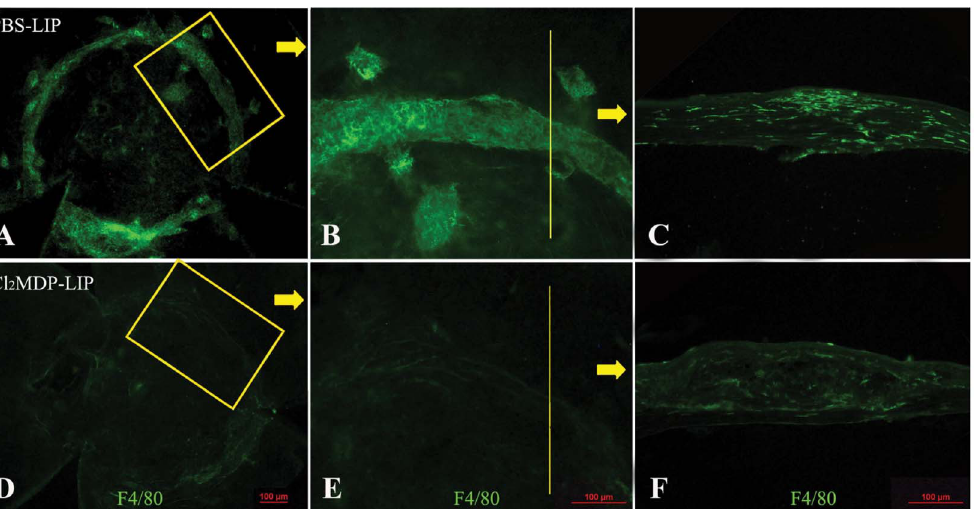
Figure 2. Sub-conjunctival Cl 2 MDP-LIP injection prevented the infiltration of macrophages. Corneal flat mount staining after 14 days of penetrating keratoplasty showed a number of F4/80 + macrophages near the suture sites and around the junction between the graft and recipient cornea (A, B). Section staining primarily revealed staining clustered in the superficial corneal stromal layer (C), while few macrophages could be found in the junction and suture area in Cl 2 MDP-LIP-injected mice (D–F).